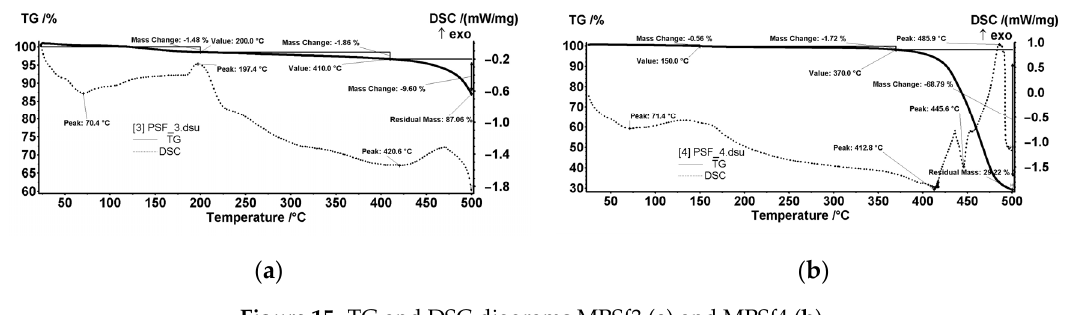
Figure 15. TG and DSC diagrams MPSf3 ( a ) and MPSf4 ( b